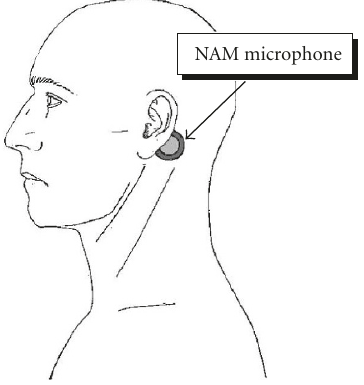
Figure 1: NAM microphone attached to the talker.